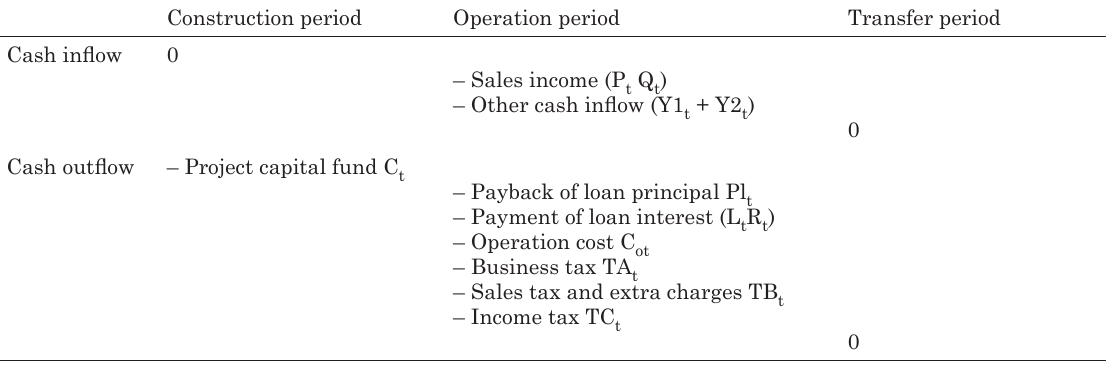
table 1. Simplified cash flow of project capital fund from the perspective of the private